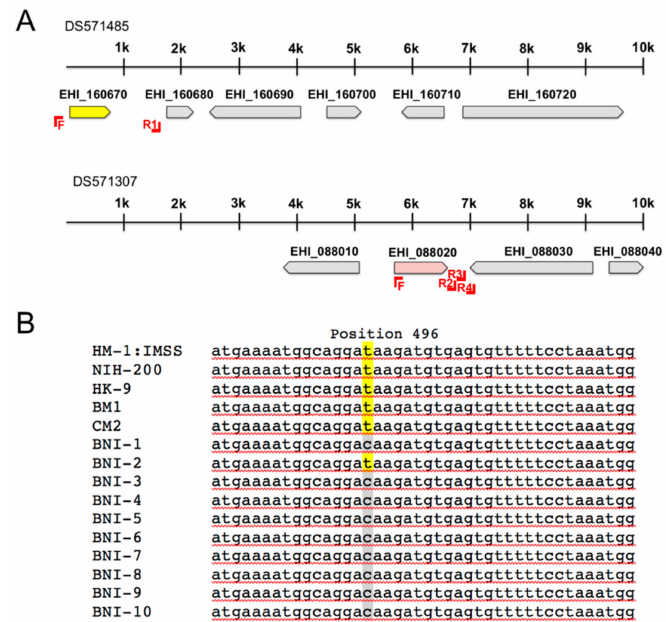
Figure 1. Localization of the EhADH3B coding genes EHI_160670 (ehadh3b a ) and EHI_088020 (ehadh3b b ) in the genome of E. histolytica (AmoebaDB, release 48 beta, 27 August 2020) and sequence analysis of EHI_088020 of di ff erent E. histolytica isolates. ( A ). The gene EHI-160670 (yellow) is located at the beginning of the contig DS571485 and the gene EHI_088020 (red) is located in contig DS571307 at position 5583 to 6731. The genomic region around the genes EHI_160067 and EHI_088020 was amplified and sequenced in 14 di ff erent E. histolytica isolates using the primers shown in A . ( B ). In EHI_088020 a mutation at position 496 (C-T (yellow)) coding for a stop codon was identified in some of the isolates